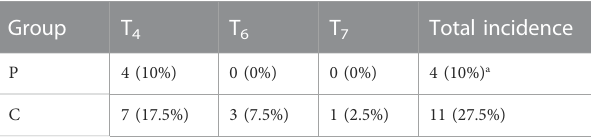
TABLE 3 POD incidence at different time points in the two groups [n